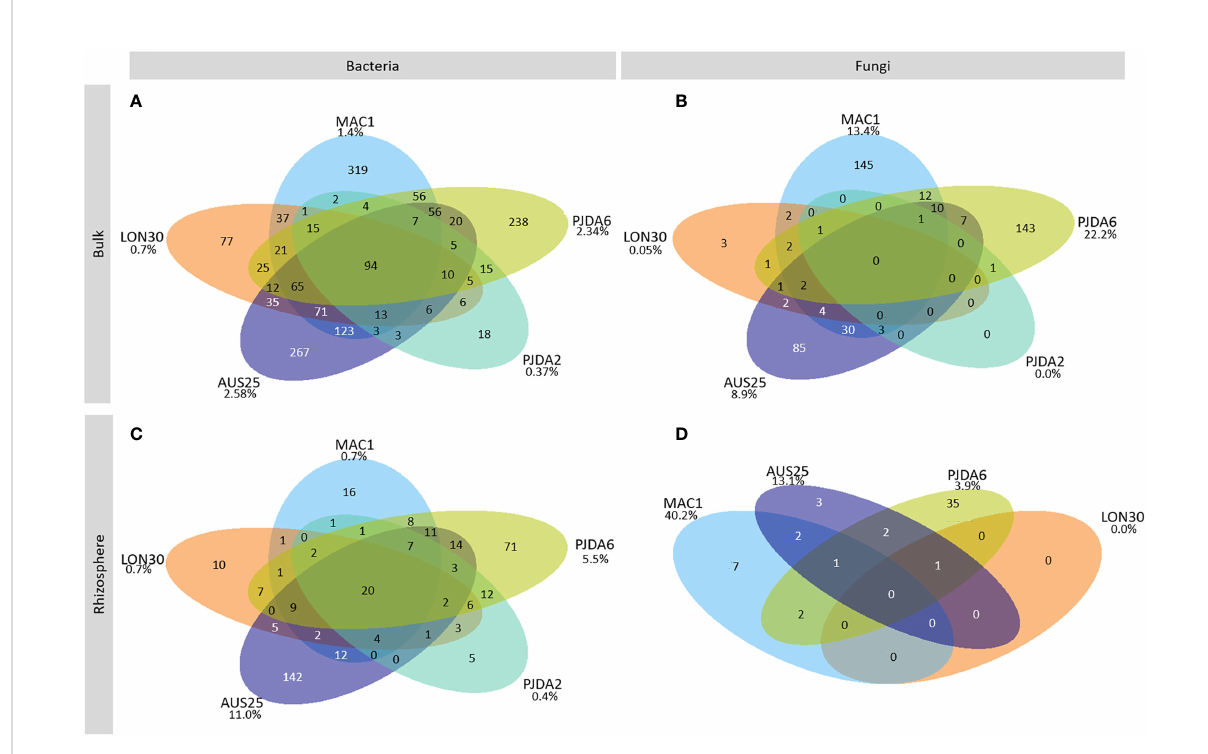
FIGURE 3 Venn diagrams of the soil core microbiome for (A) bacteria and (B) fungi and the core rhizomicrobiome for (C) bacteria and (D) fungi. The numbers indicate the number of OTUs in each conditions. The percentages represent the amount of OTUs speci fi c to a site compared to the overall core soil OTUs of the same site. The soil from PJDA2 did not have any fungal core